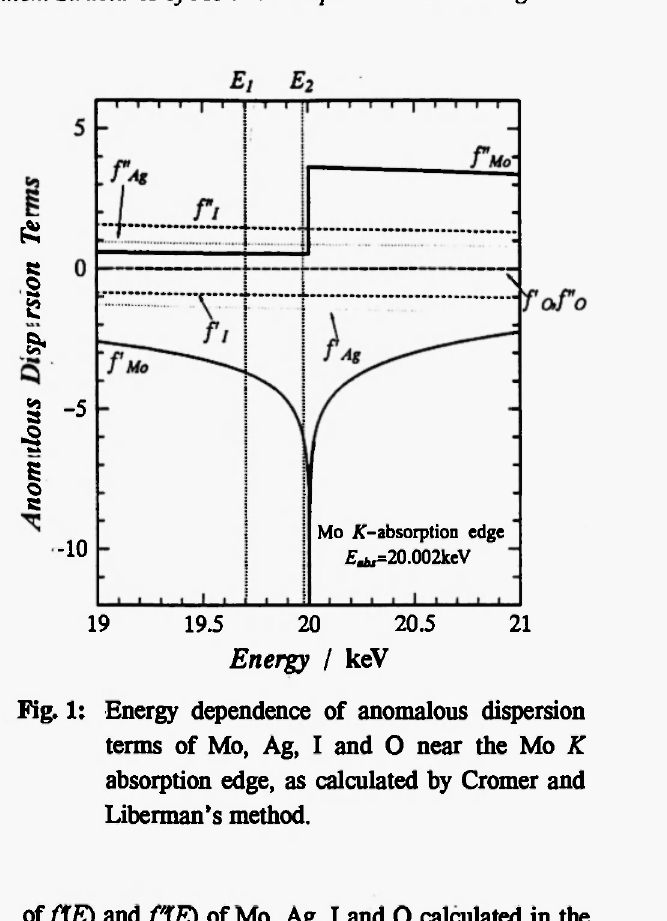
Fig. 1: Energy dependence of anomalous dispersion terms of Mo, Ag, I and Ο near the Mo Κ absorption edge, as calculated by Cromer and Liberman's method.